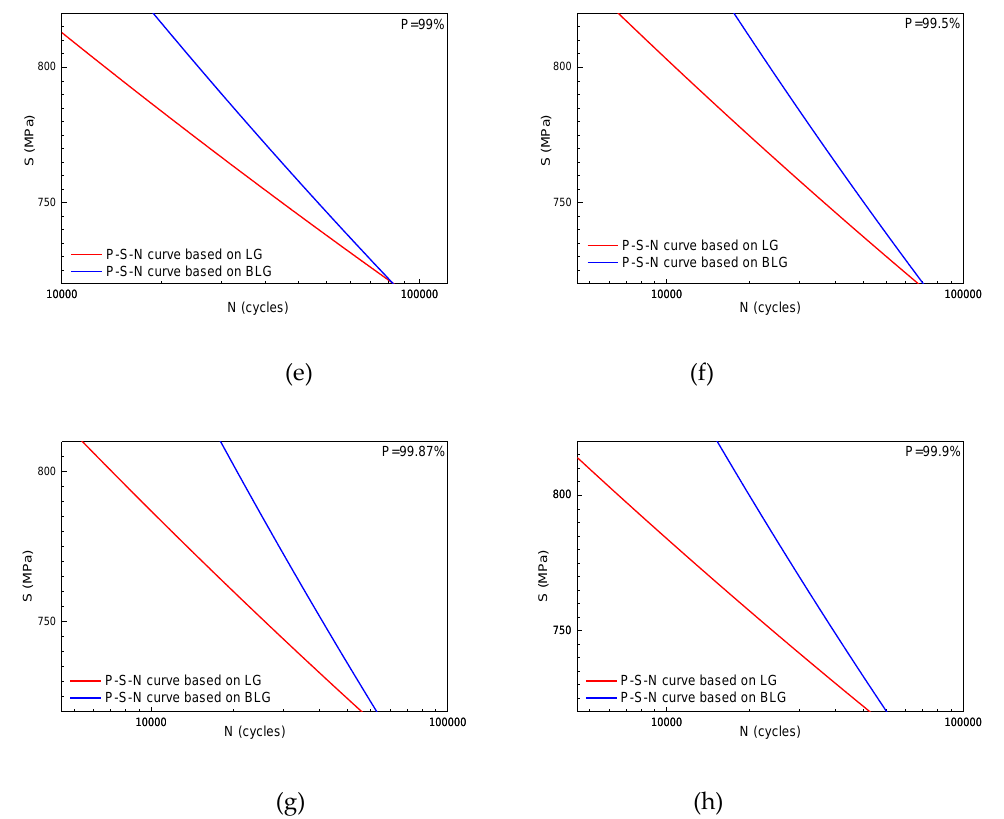
Figure 14. P-S-N curves based on an LG and BLG under reliabilities of ( a ) 50%, ( b ) 80%, ( c ) 90%, ( d )